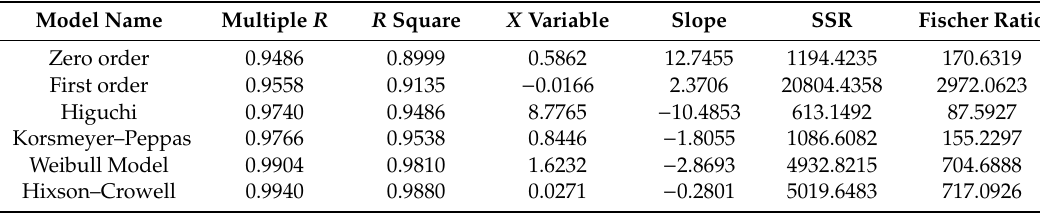
Figure 4. Comparison of percentage moxifloxacin release from prepared nanoemulsions (MM1– MM7) and drug solution (control). The data represents average ± SD of six trials. and drug solution (control). The data represents average ± SD of six trials. Table 3. Model fitting for selected nanoemulsion